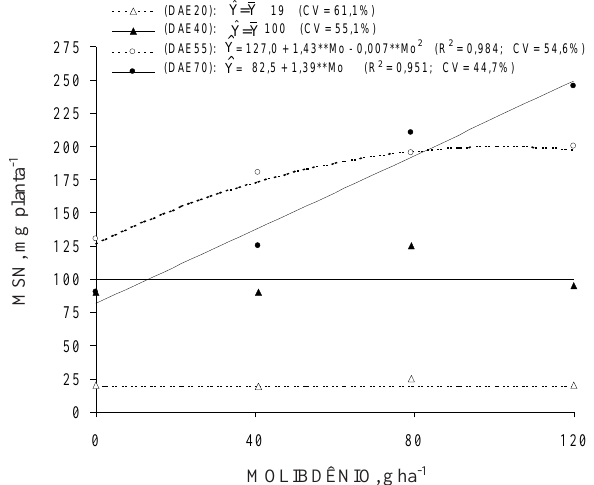
Figura 3. Matéria seca de nódulos (MSN) aos 20, 40, 55 e 70 dias da emergência (DAE) do feijoeiro cv. Ouro Negro, considerando a adubação foliar com molibdênio. ** significativo a 1% pelo teste t.